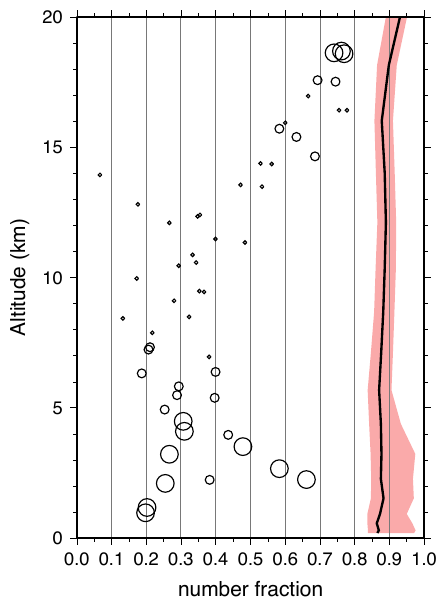
Fig. 15. Number fraction of internally mixed BC particles as calculated by Schwarz et al. (2008) from observations taken dur- ing the CR-AVE campaign (open circles) and as simulated by EMAC/MADE-in (shaded area) in the simulation BCACC90. The solid line is the median value and the shaded areas are defined by the 10% and 90% percentiles. Each open circle corresponds to a 1-km average from one flight with the symbol diameter roughly propor- tional to its statistical confidence; large, medium, and small sym- bols correspond to < 5%, < 10%, and < 25% statistical uncertainty, respectively.